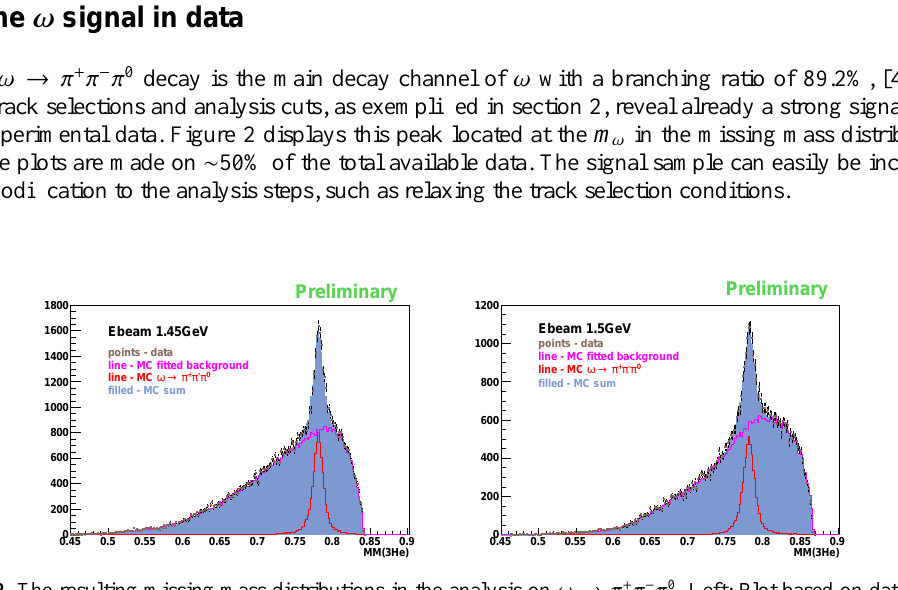
Fig. 2. The resulting missing mass distributions in the analysis on ω → π + π − π 0 . Left: Plot based on data taken with a kinetic energy at 1.45 GeV for the beam protons. Right: Plot based on data taken with 1.5 GeV kinetic beam